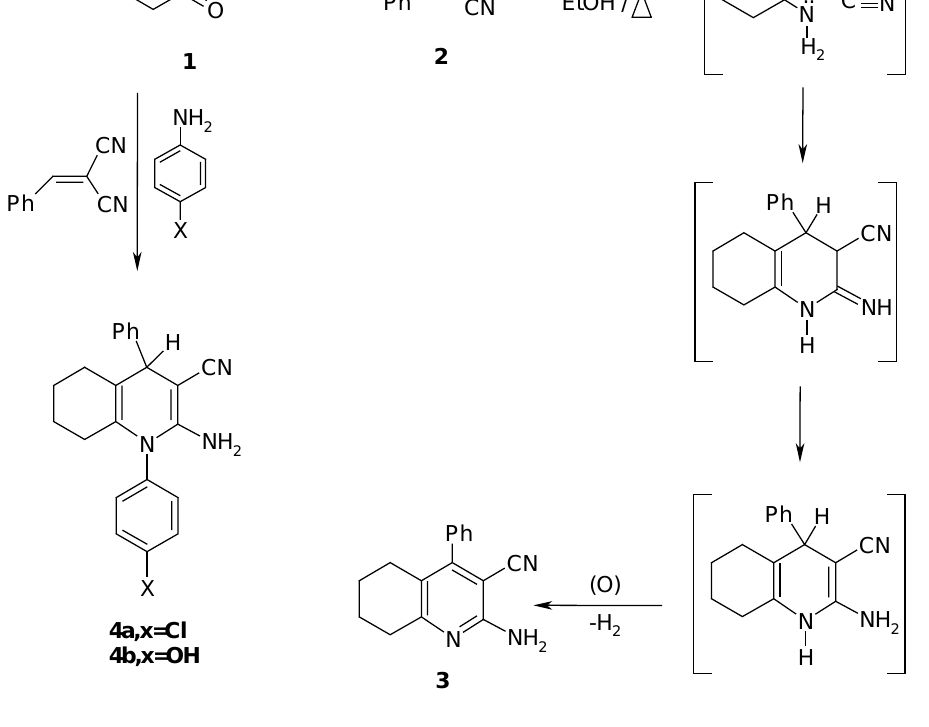
Figure 1. ORTEP diagram of compound